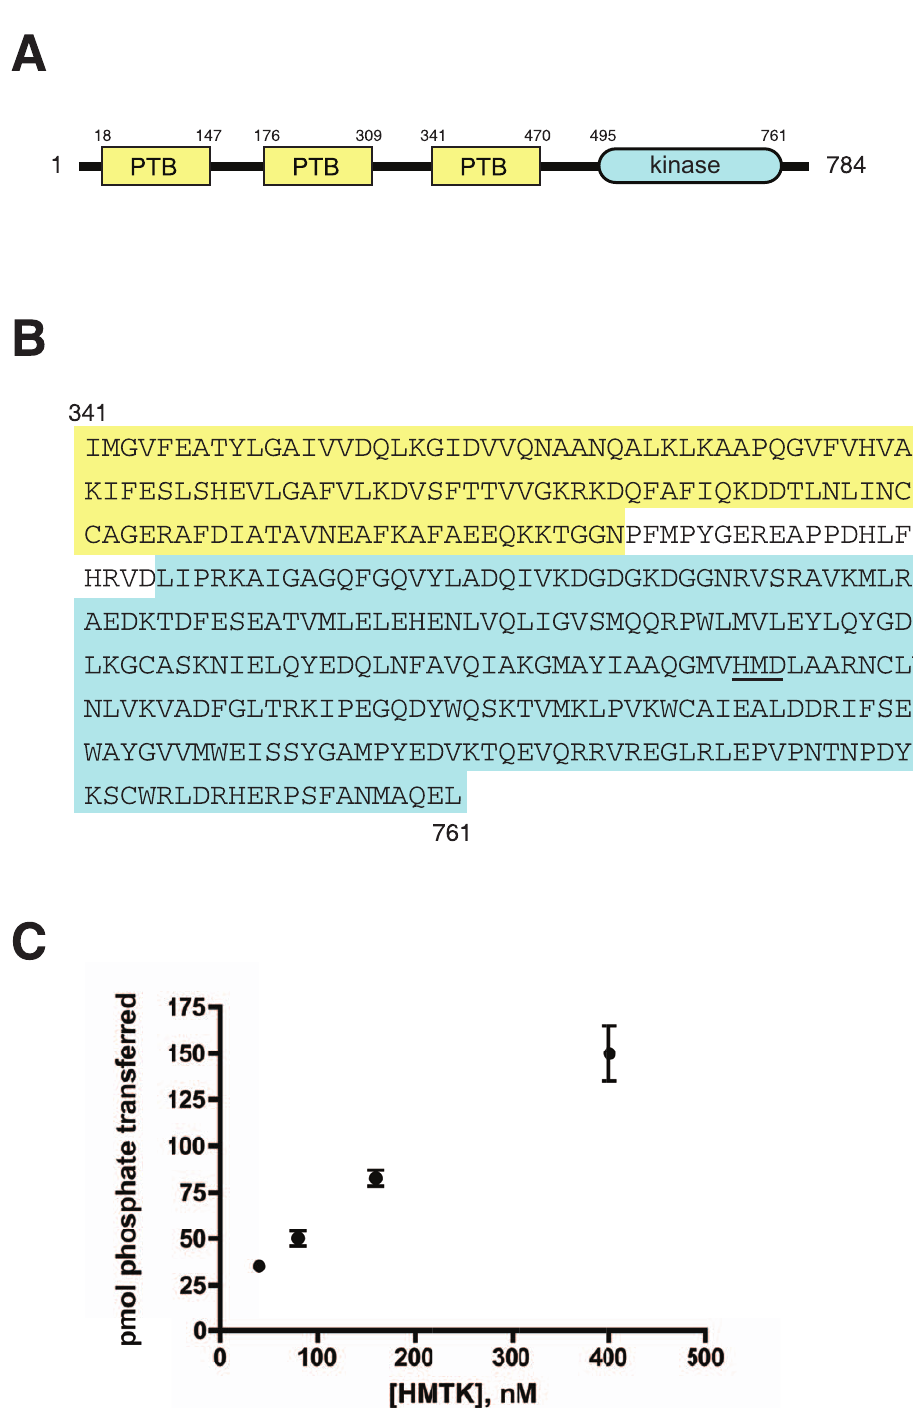
Figure 1. Monosigabrevicollis HMTK1 kinase. (A) Domain arrangement of HMTK1. (B) Amino acid sequence of the PTB-kinase HMTK1 construct used in this study. The HMD motif in the catalytic loop is underlined. (C) Tyrosine kinase activity of HMTK1. Purified HMTK1 (at the indicated concentrations) was assayed with the c-Src peptide (500 m M). Reactions proceeded for 6 minutes at 30 u C, and enzyme activity was measured using the phosphocellulose paper assay. doi:10.1371/journal.pone.0019296.g001 blotting of SYF cell lysates showed no significant activity for substrates. We expressed FLAG-tagged HMTK1 in SYF cells to HMTK1 (wild-type or mutants) over the background levels seen in reduce background phosphorylation. For comparison, we also untransfected SYF cells (Figure S4A). Treatment of SYF cells with expressed D PTB, as well as two point mutants containing amino sodium orthovanadate enhanced overall phosphorylation, but no acid substitutions that could potentially disrupt PTB-phosphotyr- difference was apparent between untransfected and HMTK1- osine interactions (Figure S3). Anti-phosphotyrosine Western